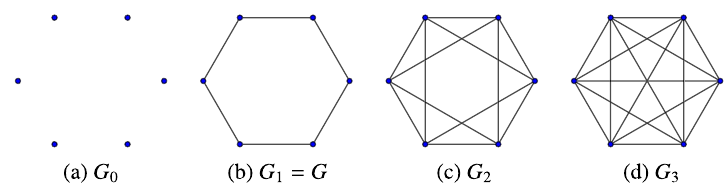
Fig. 4 The hexagonal network G = G 1 in Example 3.1 is filled in as i increases from 0 to 3. This produces the simplicial complexes G 0 , G 1 , G 2 , G 3 shown left to